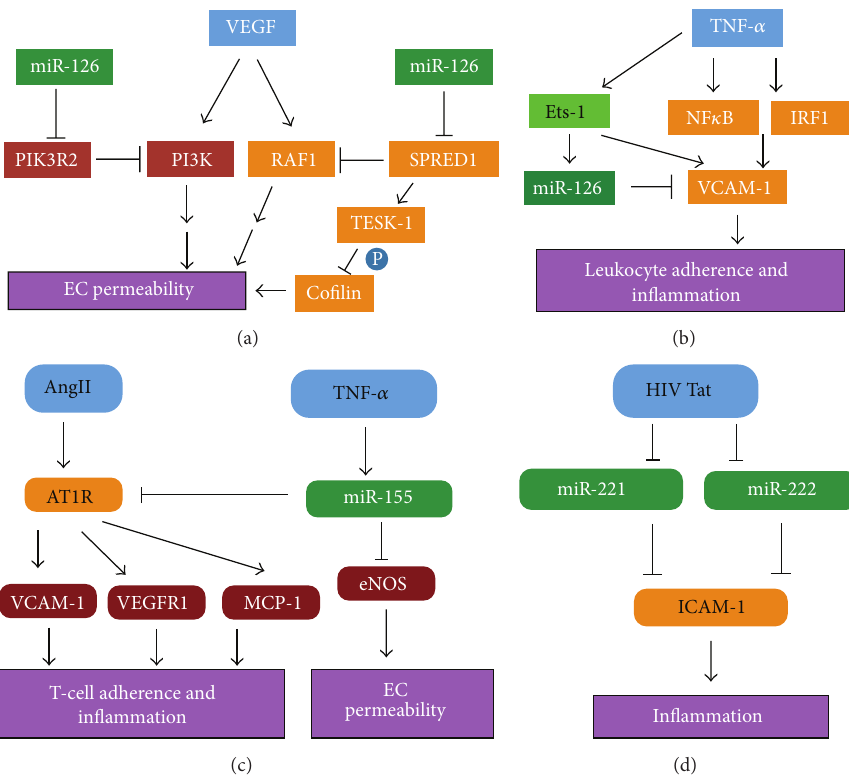
Figure 2: Roles of miR-126, miR-155, miR-221, and miR-222 in endothelial cell inflammation and maintenance of vascular integrity. (a) miR-126 regulates EC permeability through inhibition of PI3K and MAPK signaling pathways. miR-126 regulation of SPRED1 also indirectly regulates phosphorylation of cofilin and protein involved in maintenance of EC junctions. (b) Increased miR-126 levels result in a decrease in VCAM-1 levels, providing an anti-inflammatory effect. (c) miR-155 inhibits eNOS synthesis and thereby regulates EC permeability. Additionally, miR-155 inhibits Angiotensin-1 Receptor (AT1R) signaling, decreasing the expression of proinflammatory factors in EC. (d) HIV proteinTatcanreducetranscriptionofmiR-221andmiR-222,releasingtheirblockadeonICAM-1translationandresultinginaninflammatory